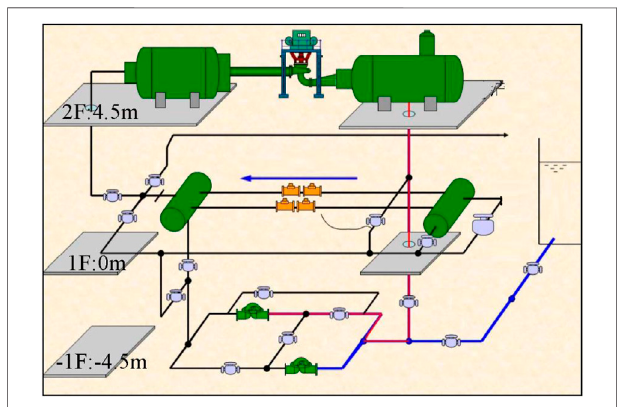
FIGURE 10 | Hydraulic machinery general test bench system.